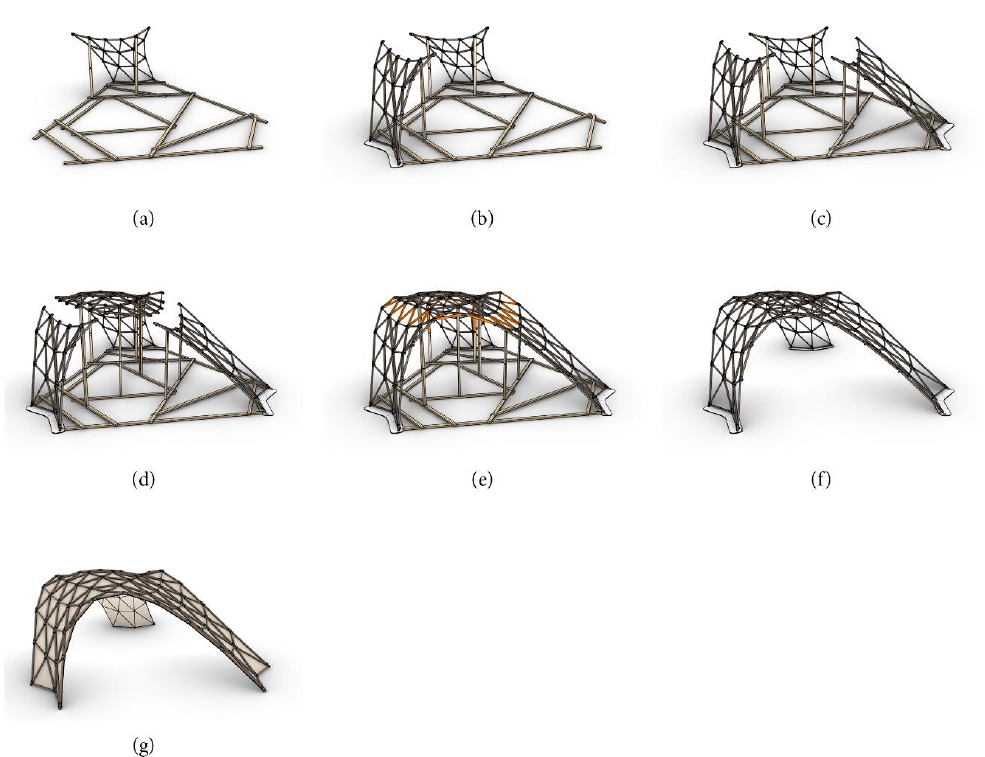
Figure 13. Assembly of the pavilion ( a ) ready assembled falsework and assembly of supersize element 1; ( b ) assembly of supersize element 2; ( c ) assembly of supersize element 3; ( d ) assembly of supersize element 4; ( e ) assembly of the loose members (orange); ( f ) removal of the falsework; ( g ) mounting of the panels.